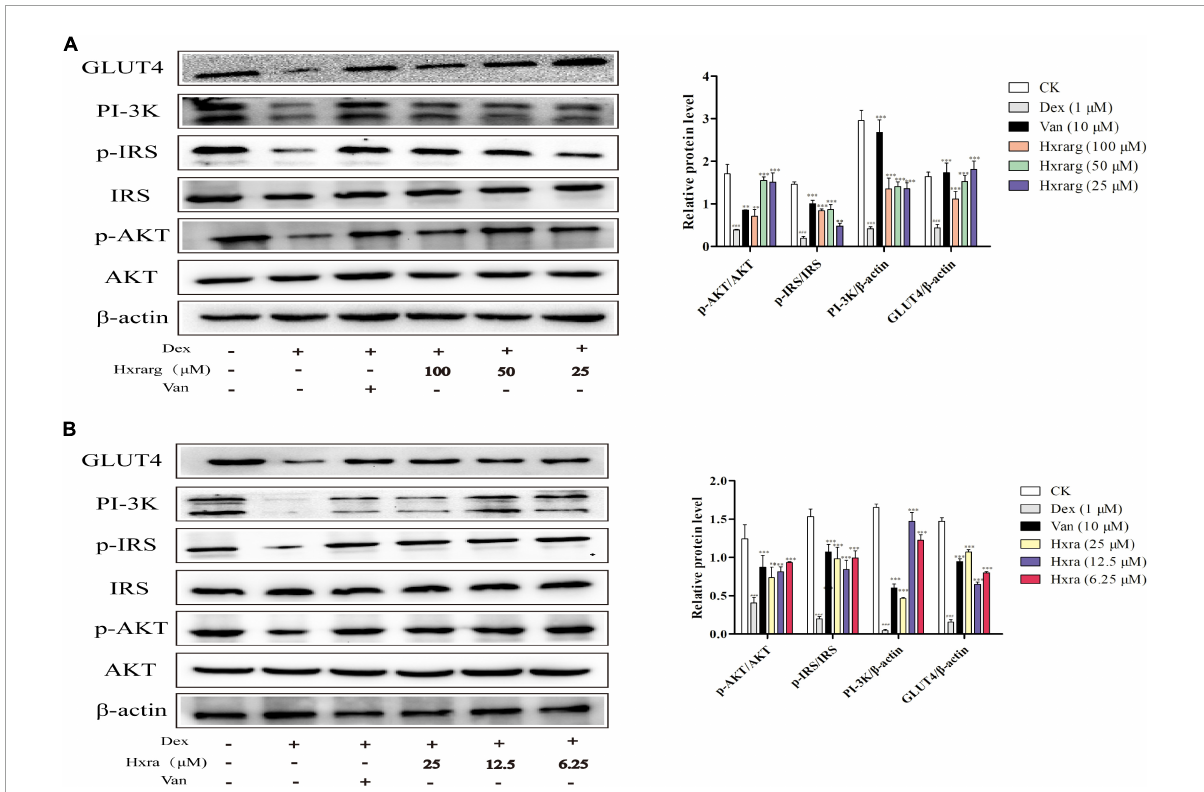
FIGURE8 The effects of Hxrarg (A) and Hxra (B) on protein expression in IR adipocyte signaling pathway. Compared with the control, ### P < 0.001; compared with the model group, ∗ P < 0.05, ∗∗∗ P <